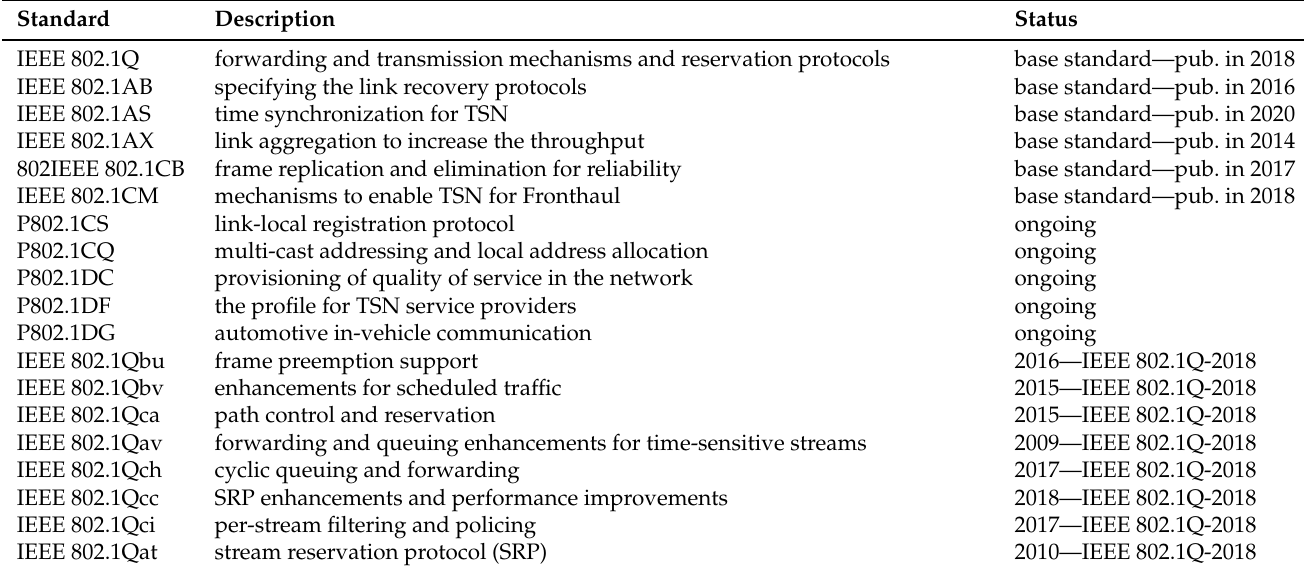
Table 1. Functions and features of TSN that will enable the introduction of security mechanisms